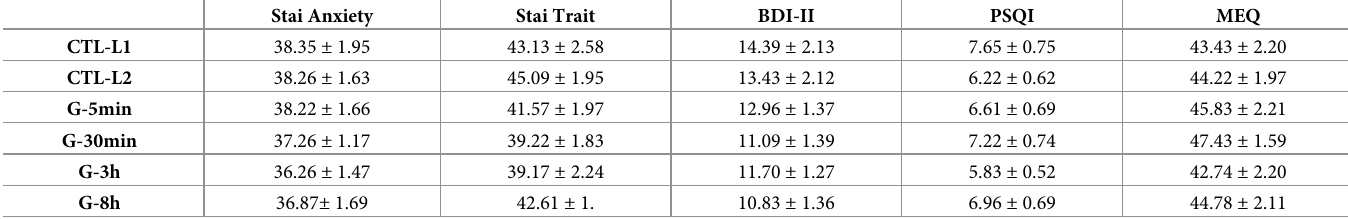
Table 1. Emotional variables and questionnaires.